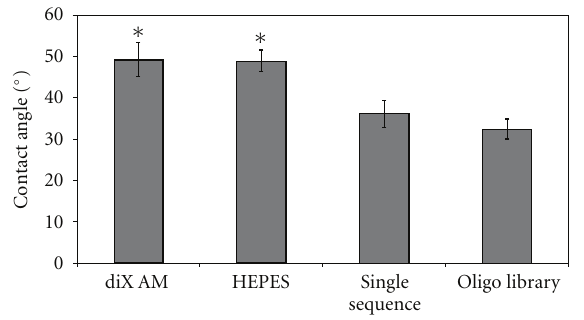
Figure 3: Oligonucleotide coating stability. Polypropylene sheets were coated with diX AM and oligonucleotides were applied to the coated surface. Oligonucleotides were detected by an ELISA system. Samples were exposed to a constant fluid flow inducing at least 9, 5N/m 2 shear stress on the surface for 1h ( n =